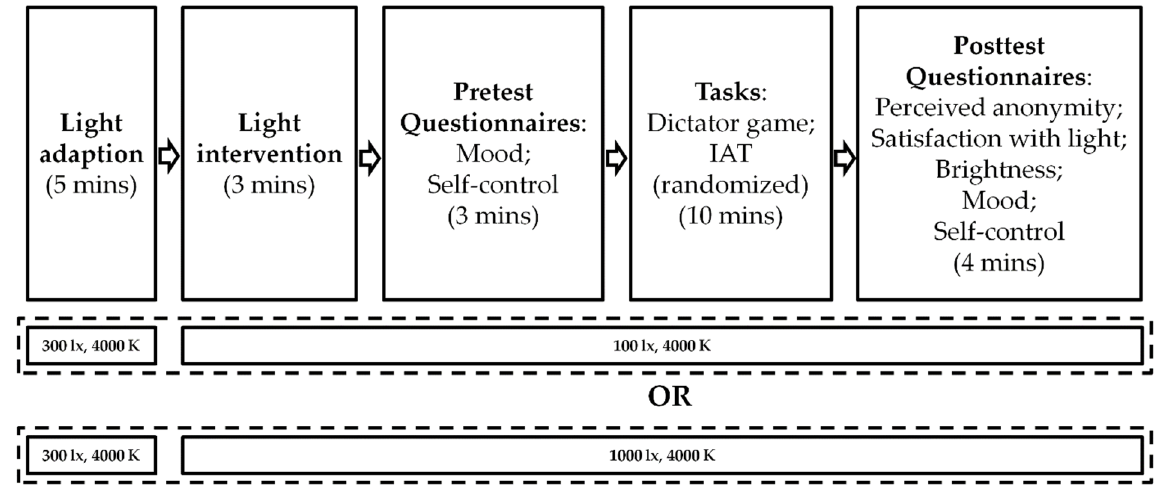
Figure 3. A schematic representation of the overall study protocol.